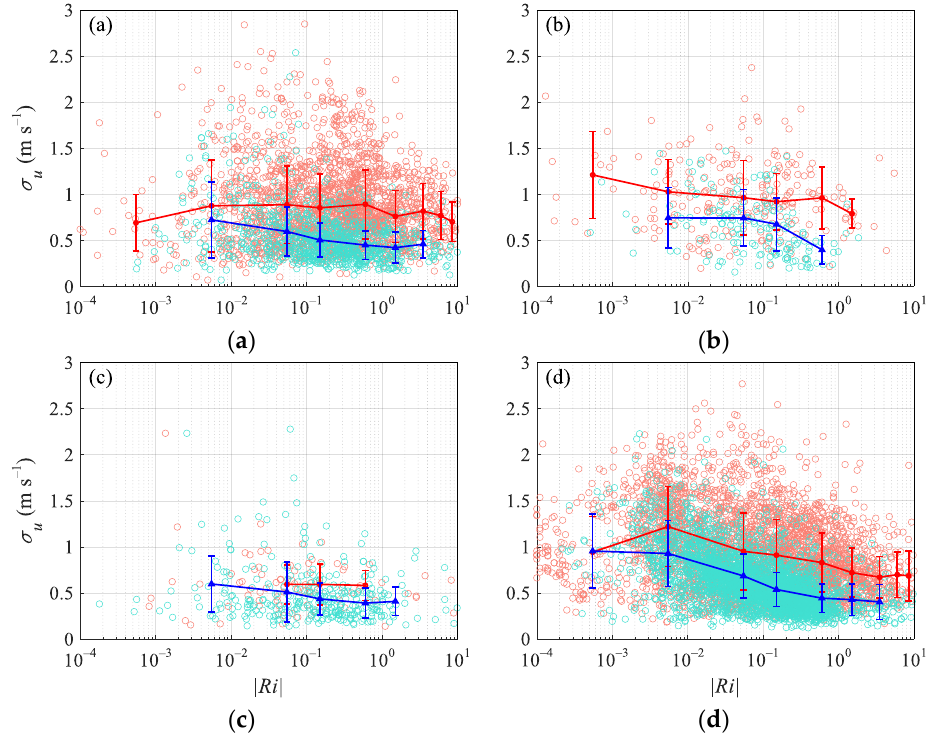
Figure 6. The dependence of the horizontal longitudinal wind standard deviation, σ u , on the stratification stability Ri ( a ) northwest, ( b ) northeast, ( c ) southwest, ( d ) southeast. The scattered points represent the average value of each record. The curves represent the average value of different Ri intervals, and the error bars represent the standard deviation of each interval. The unstable and stable conditions are indicated in red and blue colors,